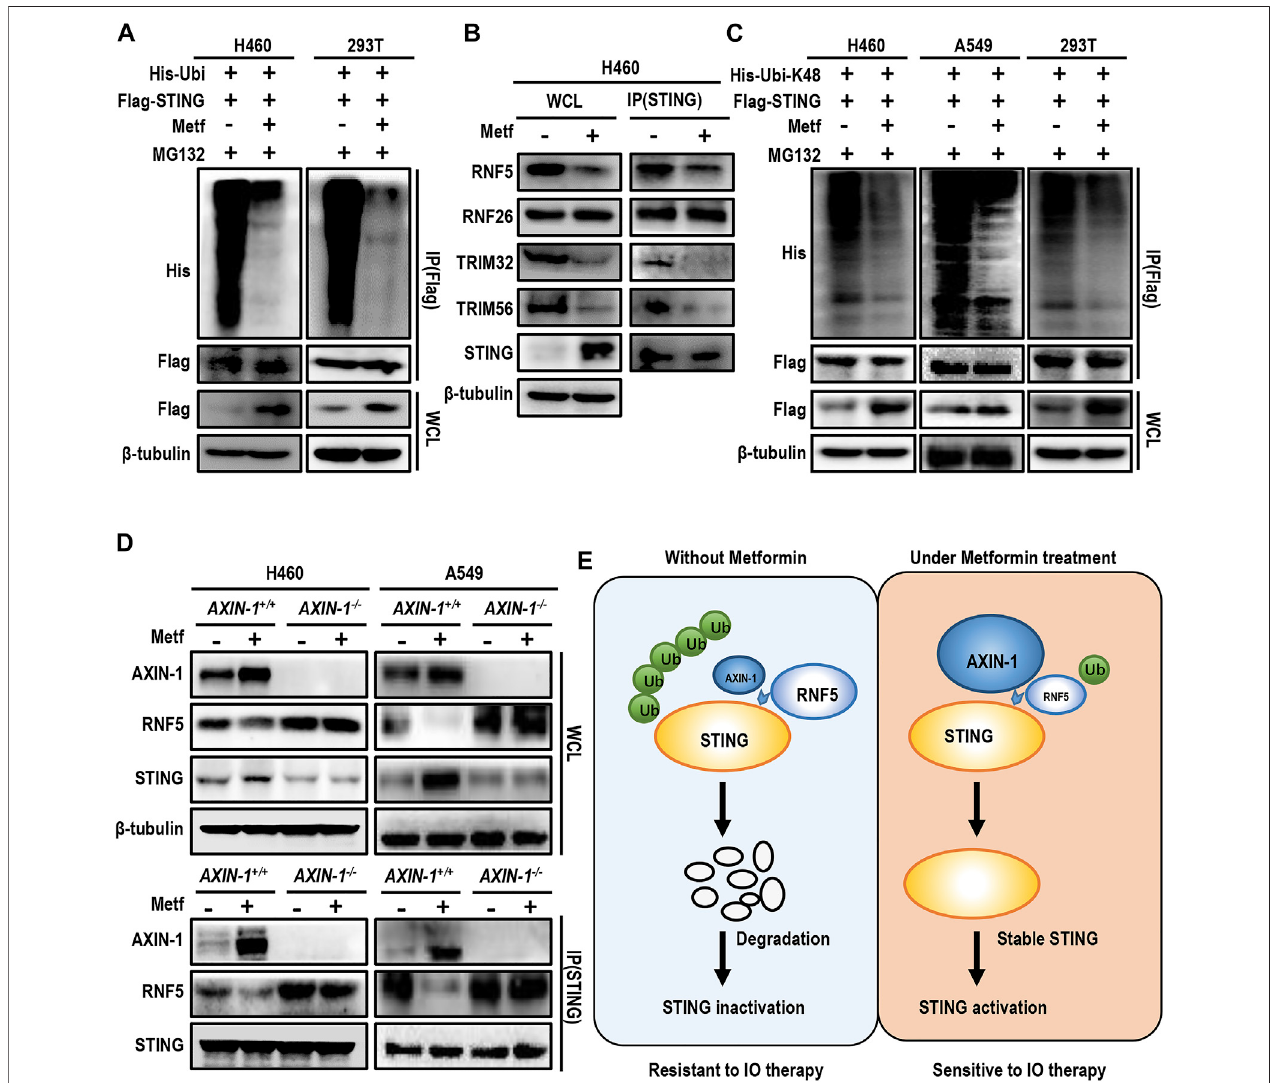
FIGURE 6 | AXIN-1 promotes stabilization of STING via competitive inhibition of RNF5-mediated K48-linked ubiquitination of STING. (A) , H460 cells and HEK293T cells were transiently transfected with the indicated plasmids with MG132 for 12 h. Immunoprecipitation analysis of exogenous STING ubiquitination with the indicated antibodies. (B) , Cell lysates from indicated groups were immunoprecipitated with an anti-STING antibody and then immunoblotted with the indicated antibodies. (C) , Cells were transfected with the indicated plasmids and then immunoprecipitation analysis of K48-linked ubiquitination of exogenous STING was performed. (D) , Cell lysates from AXIN-1 +/+ cells or AXIN-1 − / − cells with different treatments were immunoprecipitated with an anti-STING antibody and then immunoblotted with RNF5. (E) , Working model for the mechanism of STING activation by